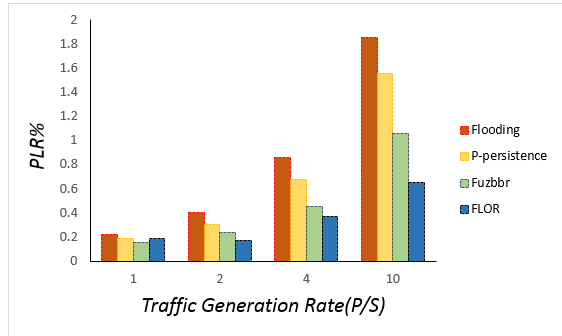
Figure 14. Packet loss ratio for different traffic generation rates.